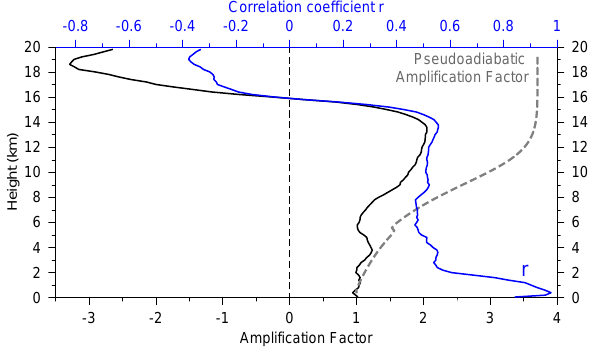
Fig. 6. The black curve shows the local temperature response asso- ciated with a 1 ◦ C increase in near surface (below 1km) tempera- ture. The dashed gray curve shows the amplification profile calcu- lated using pseudoadiabatic assumptions. The blue curve show the coefficient of correlation between the local monthly and near sur- face temperature